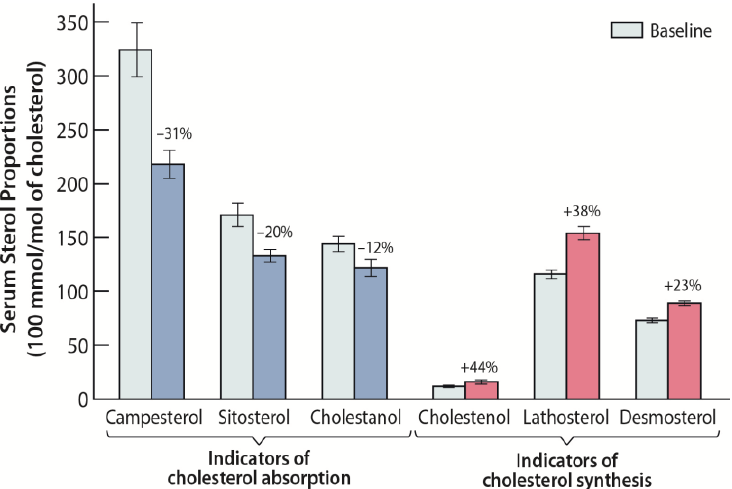
Figure 1. Effect of stanol ester margarine on serum non-cholesterol sterol proportions (100 mmol/mol of cholesterol) among 24 heterozygous familial hypercholesterolemia (he-FH) children aged 3 to 13 years [36]. Stanol ester margarine reduced the ratios of serum campesterol, sitosterol, and cholestanol